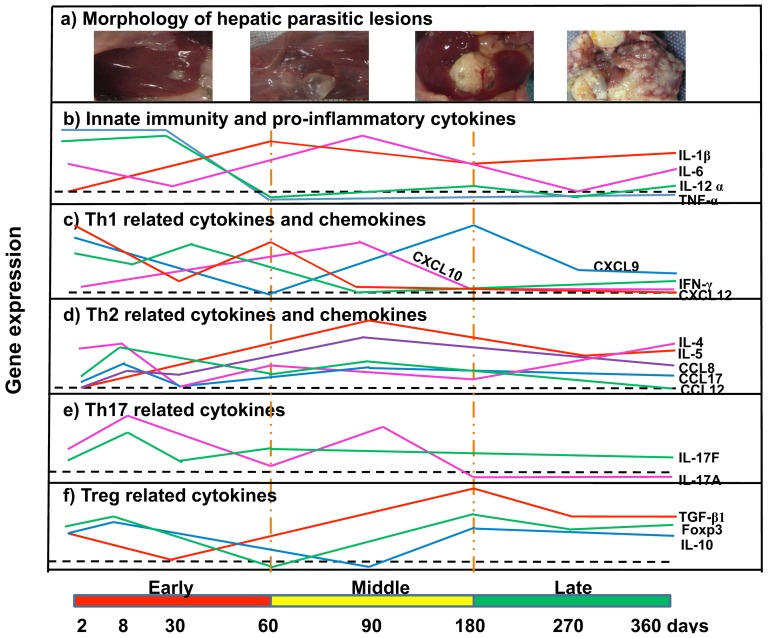
Course of the changes in the morphology of the hepatic lesions (a), gene expression of innate immunity and proinflammtory cytokins (b), Th1 related cytokines and chemokines (c), Th1 related cytokines and chemokines (d), Th17 related cytokines (e), Foxp3 and Treg related cytokines (f) during the process of E. multilocularis-infection in mice.